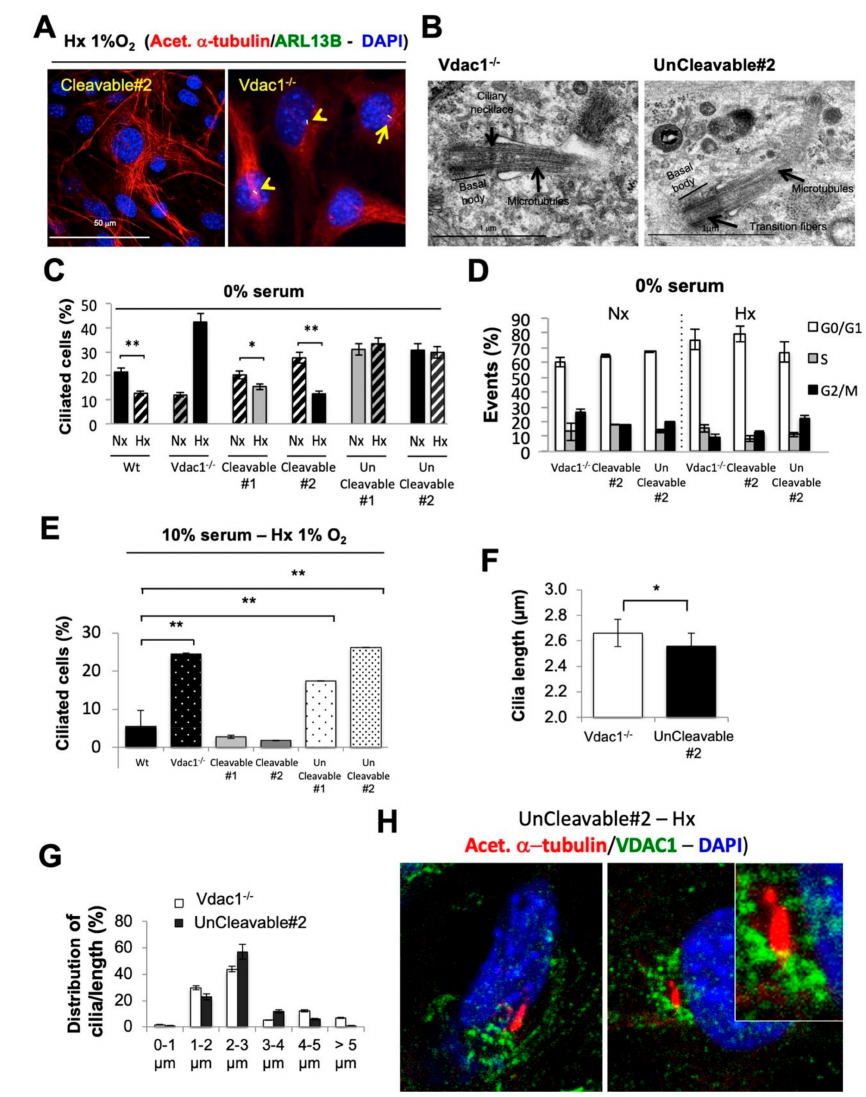
Figure 3. VDAC- ∆ C drives the resorption of the primary cilium. ( A ) Immunofluorescence of acetylated α -tubulin (acet. α -tubulin in red), ARL13B (in green) and DAPI (in blue) in Cleavable#2 and Vdac 1 − / − cells in Hx 1% O 2 for 72 h. ( B ) Representative electron micrographs of primary cilia of UnCleavable#2 cells incubated in normoxia (Nx). Axoneme (Ax), basal body, ciliary necklace, microtubules and transition fibers. ( C ) Quantitative analysis of the e ff ect of Nx and Hx 1% O 2 for 72 h on the ciliation percentage in the absence of serum (0% serum) in Wt, Vdac1 − / − , Cleavable#1 / #2, and UnCleavable#1 / #2 cells assessed by confocal fluorescence microscopy ( n = 100–300 cells). ( D ) Wt, Vdac1 − / − , Cleavable#1 / #2 and UnCleavable#1 / #2 cells were incubated in Nx or Hx 1% O 2 for in the absence of serum (0% serum). Cell cycle analysis was assessed by FACS. ( E ) Quantitative analysis of the e ff ect of Nx and Hx 1% O 2 for 72 h on the ciliation percentage in the presence of 10% serum in Wt, Vdac1 − / − , Cleavable#1 / #2, and UnCleavable#1 / #2 cells as assessed by confocal fluorescence microscopy ( n = 100–300 cells). ( F ) Average cilium length ( µ m) in Vdac1 − / − ( n = 100) and UnCleavable#2 ( n = 58) cells was assessed by confocal fluorescence microscopy. ( G ) The distribution of the average cilium length ( µ m) in Vdac1 − / − ( n = 100) and UnCleavable#2 ( n = 58) cells was assessed by confocal fluorescence microscopy. ( H ) Double staining and merge presentation of acetylated α -tubulin (acet. α -tubulin in red), VDAC1 (in green) and DAPI (in blue) in UnCleavable#2 cells in Hx 1% O 2 for 72 h. * indicates p < 0.05 and ** indicates p <